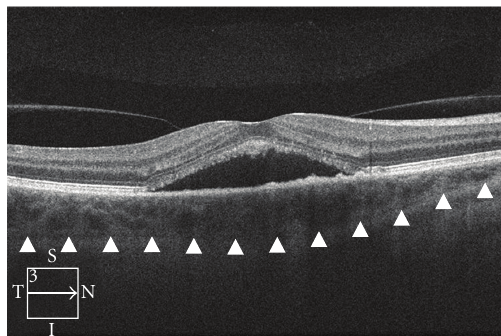
Figure 2: OCT image of retina and choroid prior to treatment de- monstrating neurosensory retinal detachment. Arrowheads mark outer boundary of choroid used to measure choroidal